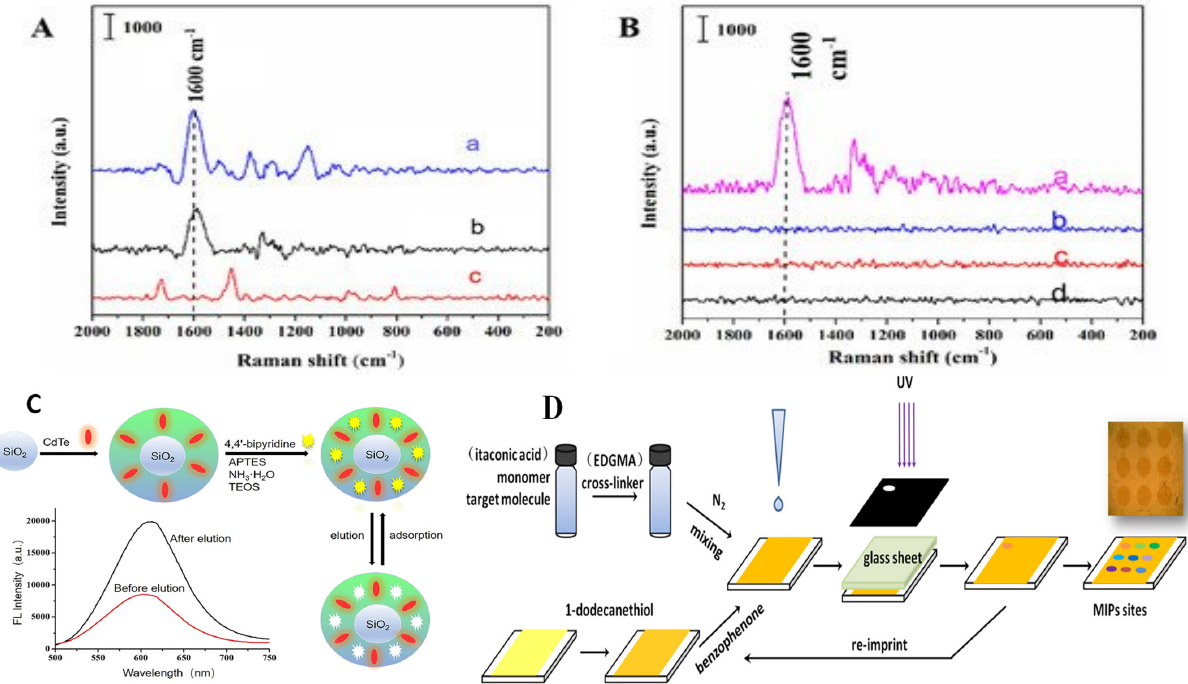
Figure 6. An illustrative scheme of some optical transduction interactions of nanocomposite MIPs in detecting various environmental analytes. Inserts ( A , B ) illustrate the surface-enhanced Raman spectroscopy spectra interactions of 1 ppm of Pentachloronitrobenzene (PCNB) with oil-soluble silver-MIP [89]. ( A ): Surface-enhanced Raman spectroscopy (SERS) spectra of PCNB with oil-soluble silver nanometer as substrate (a), MIPs absorbing 1 µ g/mL of PCNB (b), and NIPs absorbing 1 µ g/mL of PCNB (c). ( B ): The SERS spectra acquired using the oil-soluble Ag NPs-embedded MIPs as substrates after the MIPs were respectively incubated with the solutions of PCNB (a), 3,4,5-trichloronitrobenzene (b), 3,5-dichloronitrobenzene (c), and para-chloronitrobenzene (d) for 120 min at the concentration of 1.0 µ g/mL. Insert ( C ) also shows a schematic of a fluorescent silicon dioxide cadmium tellurium quantum dots (SiO 2 @CdTe QDs) MIP for the detection of paraquat in water samples. Reprinted with permission from Ref. [90] and insert ( D ) represents a surface plasmon resonance-based molecularly imprinted polymer sensor chip for the detection of antibiotics. Reprinted with permission from Ref.